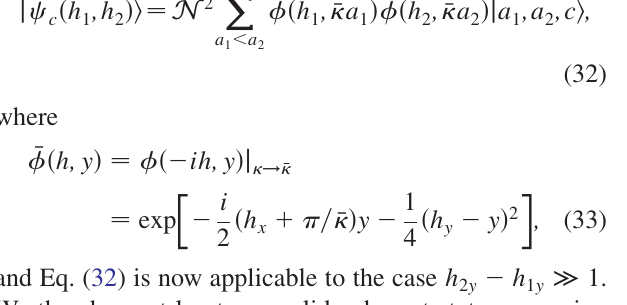
(cid:1) h Þ(cid:4) 1 x 2 x